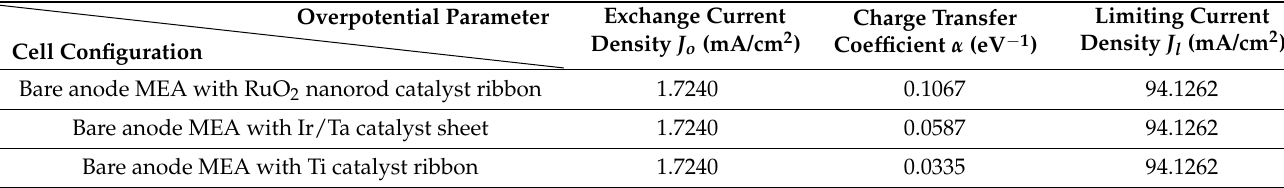
Figure 6. Tafel plot for the custom-built PEM used in this investigation with three different anode electrocatalyst materials including a detached electrocatalyst layer with IrRuO 2 (solid triangle sym- bols), Telpro ribbon mesh coated with RuO 2 nanorods (solid circular symbols), and Telpro ribbon mesh with Ir/Ta (solid square symbols). Table 1. Overpotential parameter values.